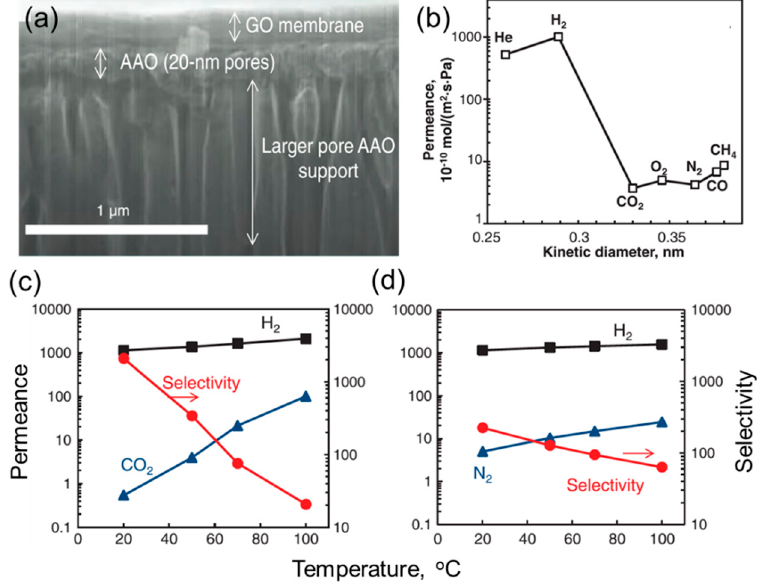
Figure 4. ( a ) Cross-sectional SEM image of a GO membrane (~180 nm) supported on porous AAO. ( b ) Gas permeances of a ~18-nm-thick GO membrane at 20 °C. Effect of temperature on mixed-gas (50:50) ( c ) H 2 /CO 2 and ( d ) H 2 /N 2 separation properties in a 1.8-nm-thick GO membrane. From [12]. Reprinted with permission from AAAS.